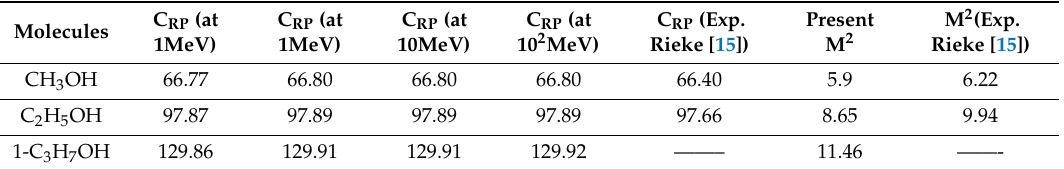
Table 2. The present calculated values of collisional parameter C RP and M 2 (in unit of a 2 along with the experimental values, given by Rieke and Prepejchal [15]. The values of C RP are calculated at incident energies 0.1, 1, 10 and 100 MeV using Equation (18).